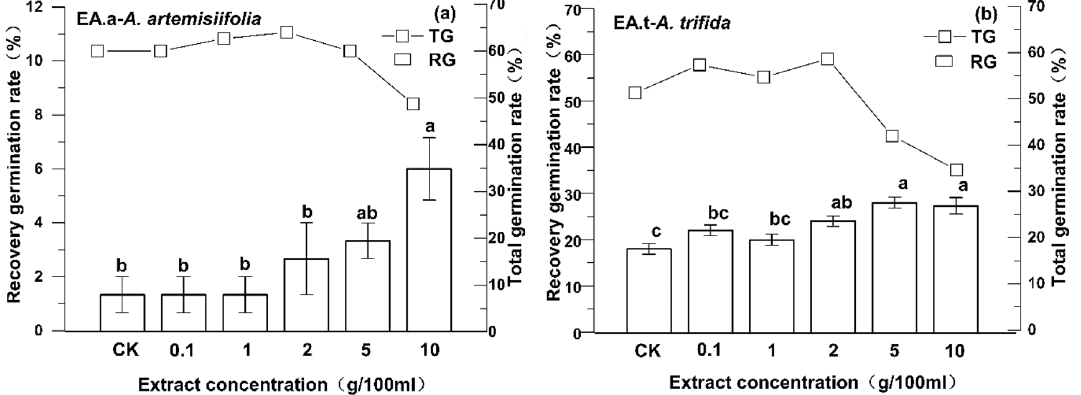
Figure 4. Recovery germination rate and total germination rate of non-germinated seeds ( a A. artemisiifolia , b A. trifida ). Lowercase letters indicate that significant differences in the recovery germination rate of non- germinated seeds at different concentrations ( p <